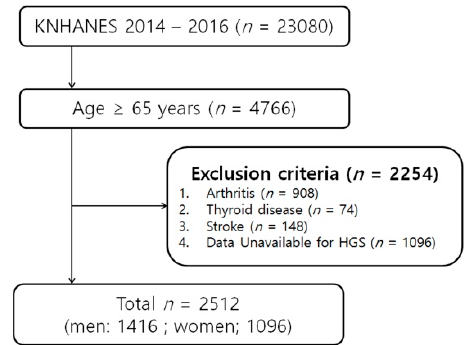
Figure 1. Study population flowchart diagram. KNHANES, Korea National Health and Nutrition Examination Survey.